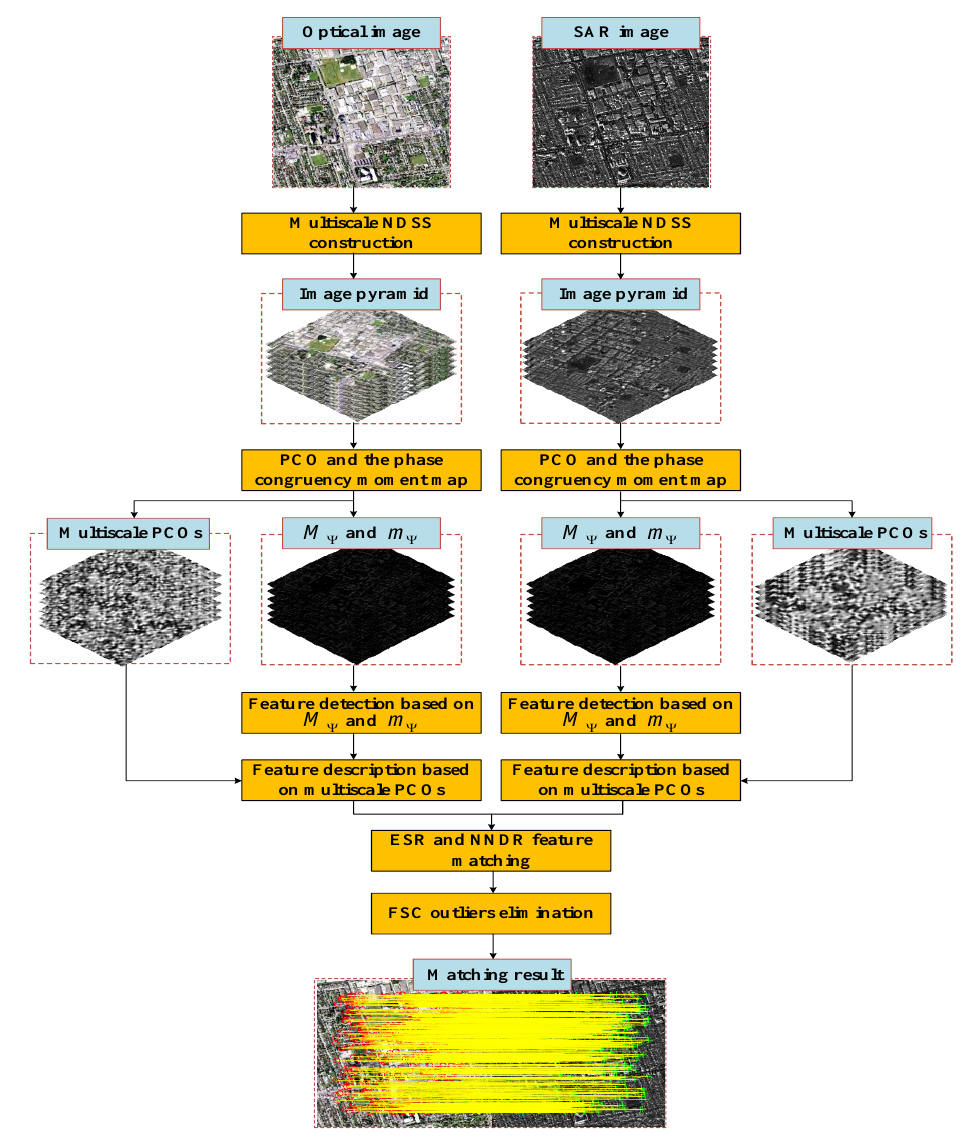
Figure 1. Flowchart of the proposed method.